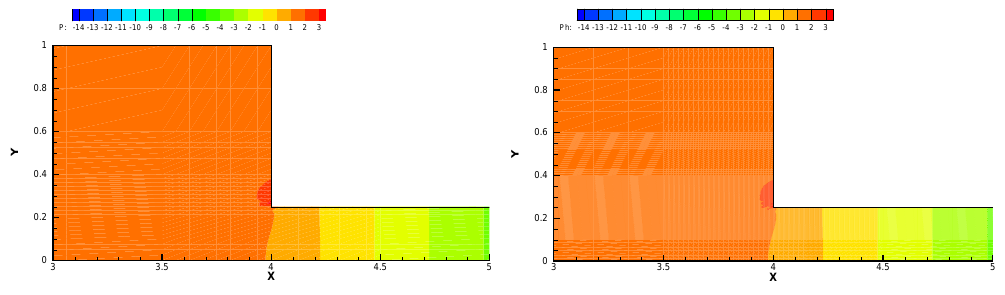
Figure 5. Representation of pressure contour p : for one-level ( left ) and two-level ( right ) method for Oseen viscoelastic fluid